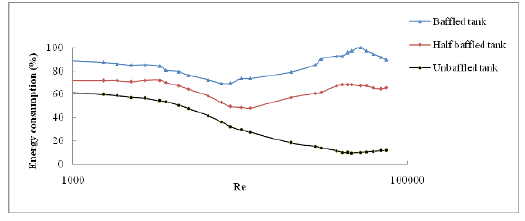
Figure 13. Evolution of the energy consumption (%).